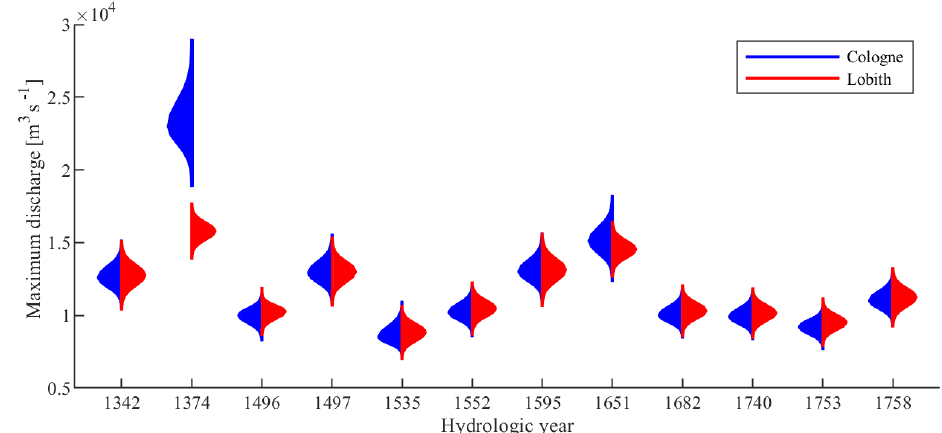
Figure 4. Maximum discharges and their 95% confidence intervals of the reconstructed historic floods at Cologne (Herget and Meurs, 2010) and simulated maximum discharges and their 95% confidence intervals at Lobith for the 12 historic flood